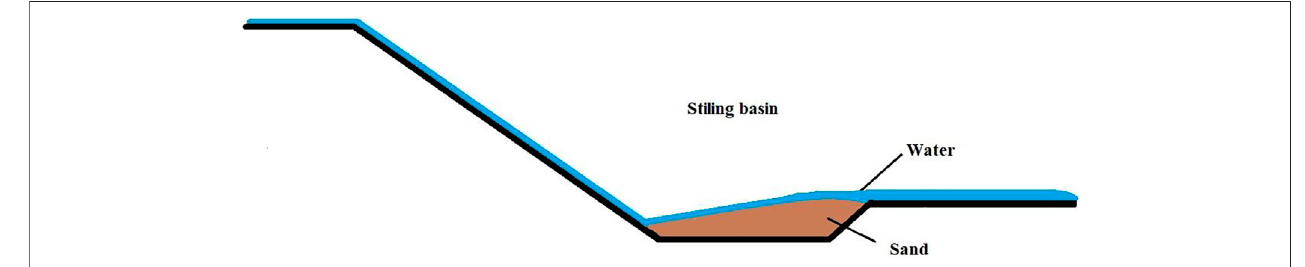
FIGURE 1 | Schematic diagram of sediment in the stilling